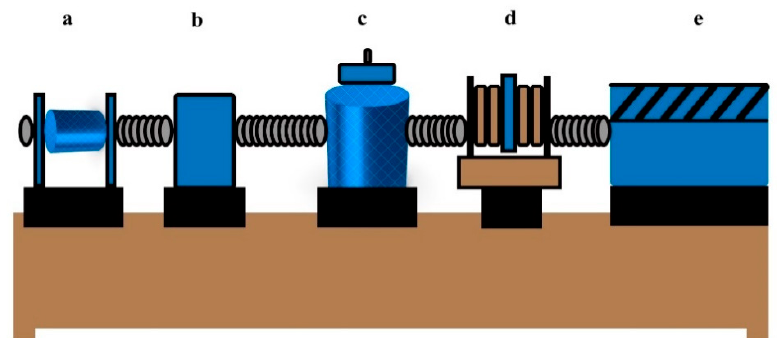
Figure 5. An illustration of Paderborn University experiment setup of bearing data acquisition and fault diagnosis. In the figure, (a) a test motor, (b) a measuring shaft, (c) a bearing module, (d) a flywheel, and (e) a load motor.